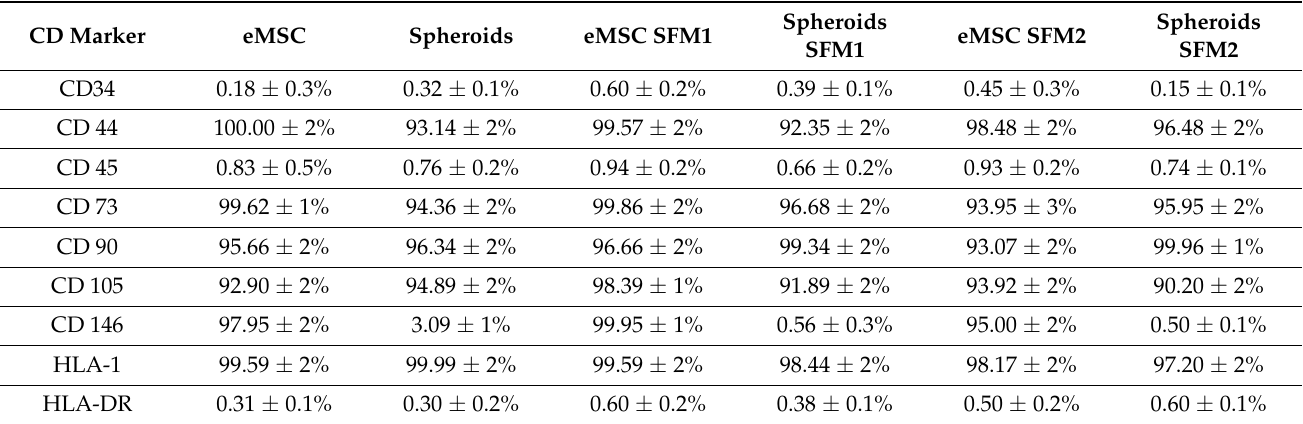
Table 1. CD expression in eMSC monolayer and spheroids under different culture